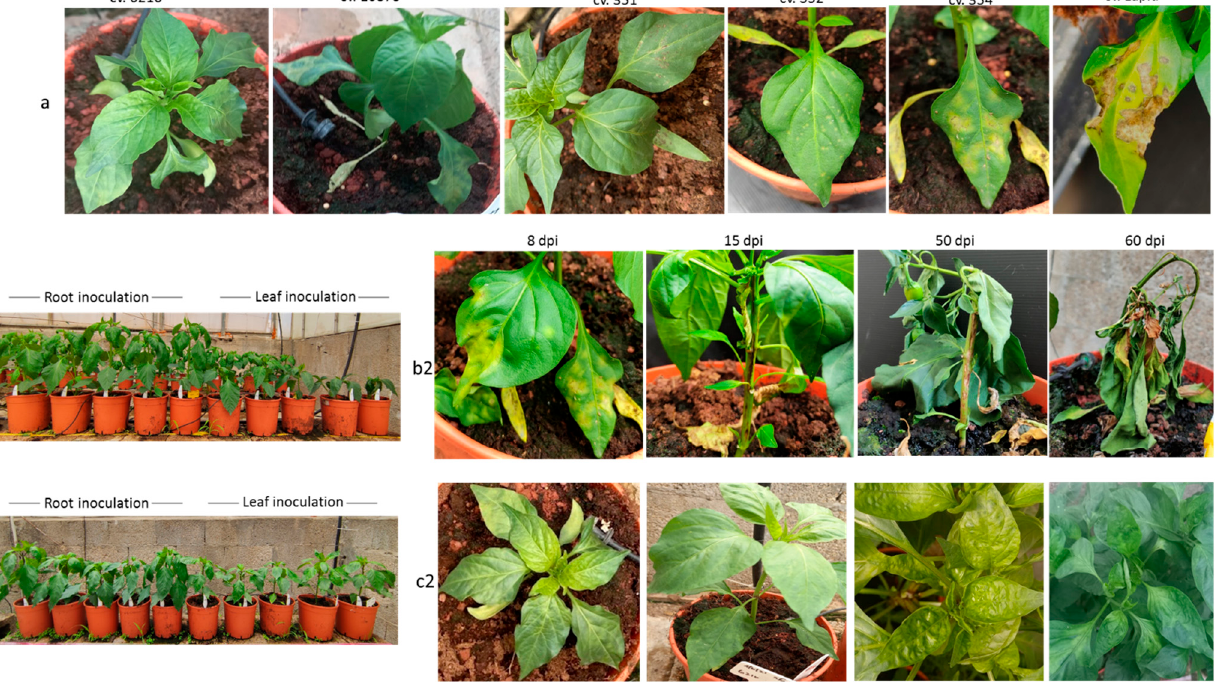
Figure 1. Response of UD pepper plant varieties as well as L 0 and L 1 plants to ToBRFV foliar inoculations: ( a ) L 0 cv. 6210 developed symptoms of yellowing and mosaic; UD plants and L 1 cv. Lapid developed a hypersensitive-like cell death response and HRs, respectively; ( b1 ) root- and leaf-inoculated plants cv. 354 at 14 days post-inoculation (dpi); ( b2 ) progression of foliar-inoculated cv. 354 toward plant death manifested at 8 dpi, 15 dpi, 50 dpi, and 60 dpi with ToBRFV-infected leaves and stems; ( c1 ) root- and leaf-inoculated L 0 cv. 6210 plants at 14 dpi; ( c2 ) progression of ToBRFV systemic infection and symptom development in foliar-inoculated L 0 cv. 6210 plants at 8 dpi, 15 dpi, 50 dpi, and 60 dpi.